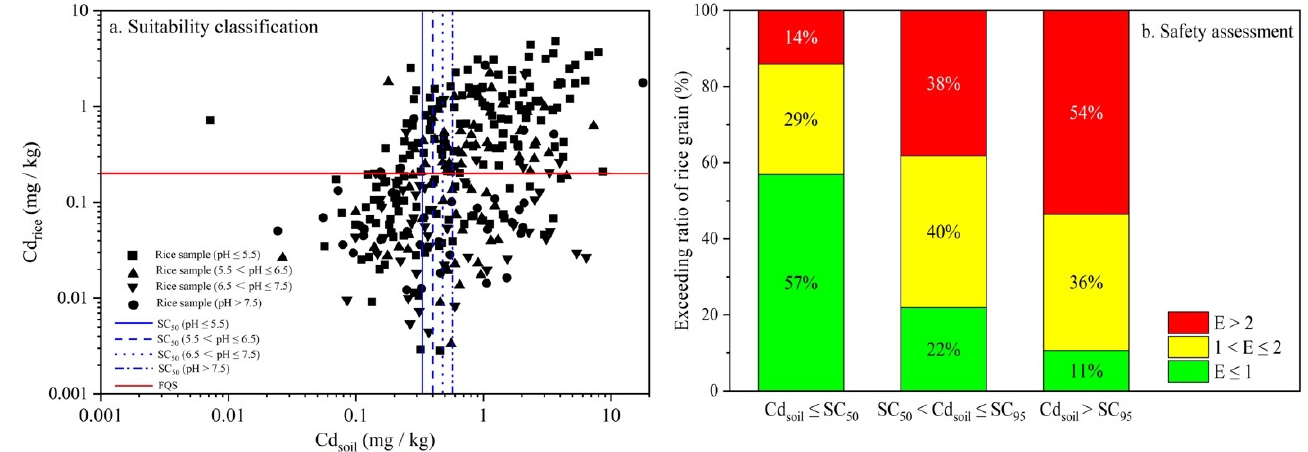
Figure 7. Suitability classification and safety assessment of rice grain samples based on SC 50 and SC 95 .